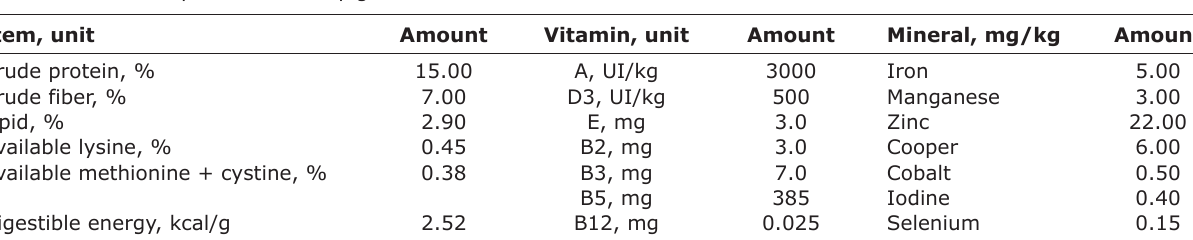
Table-1: Nutrient specifications of piglet